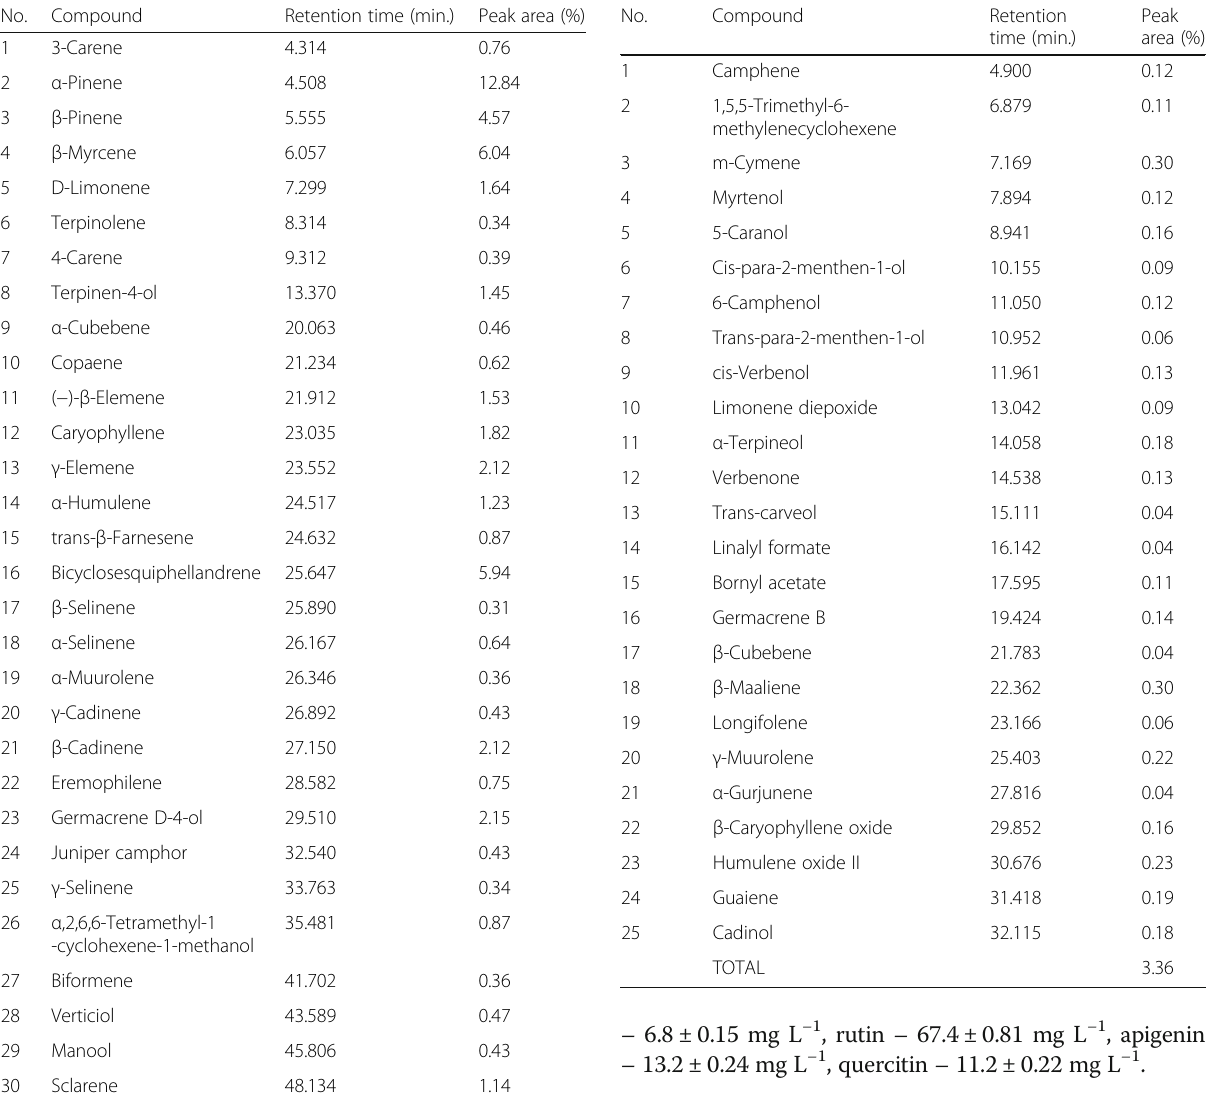
Table 4 Trace compounds identified by GC-MS in the